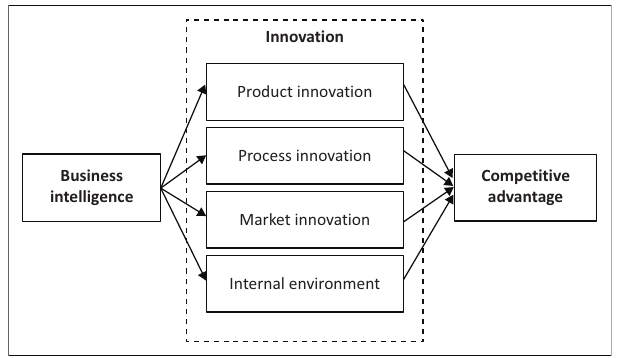
FIGURE 1: Graphical presentation of the conceptual framework of this